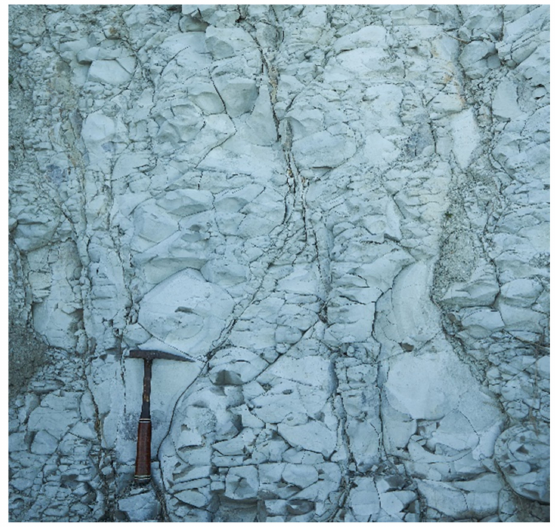
Figure 13. Complex fracturing of the Schlier formation with rugged surfaces and complex shapes of the blocks.